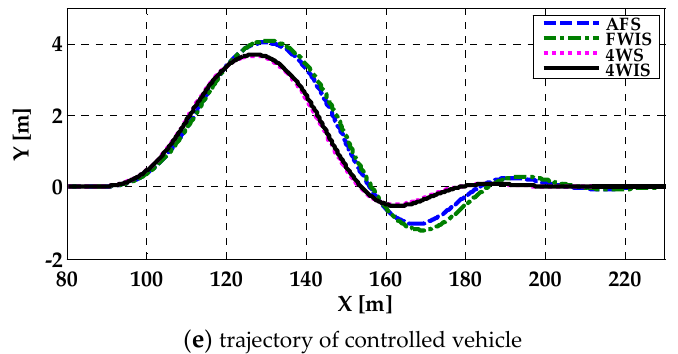
Figure 4. Simulation results for each steering actuator.